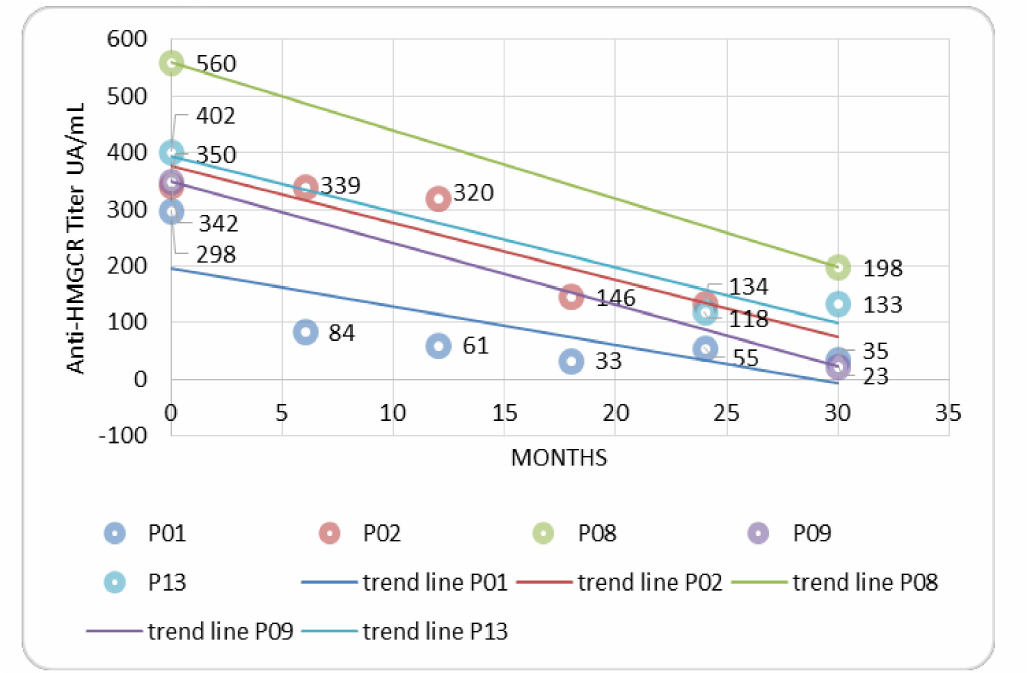
Figure 2. Anti-HMGCR antibody in patients who achieved sustained remission of disease. Legend: anti-HMGCR, anti-hydroxy-methylglutaryl coenzyme A